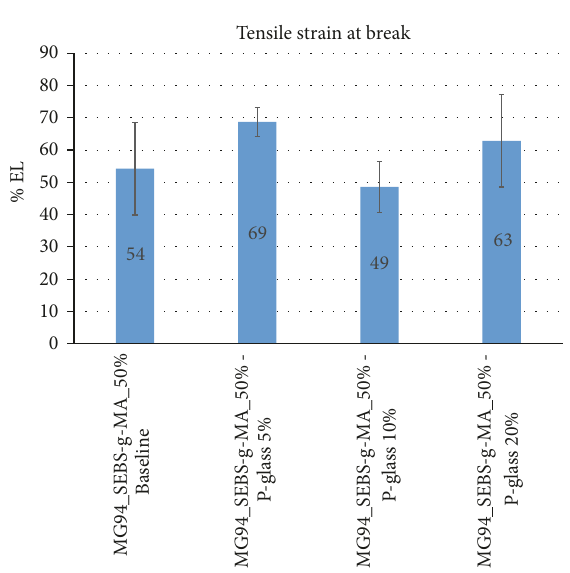
Figure 12: % EL at break values for the ABS:SEBS-g-MA P-glass